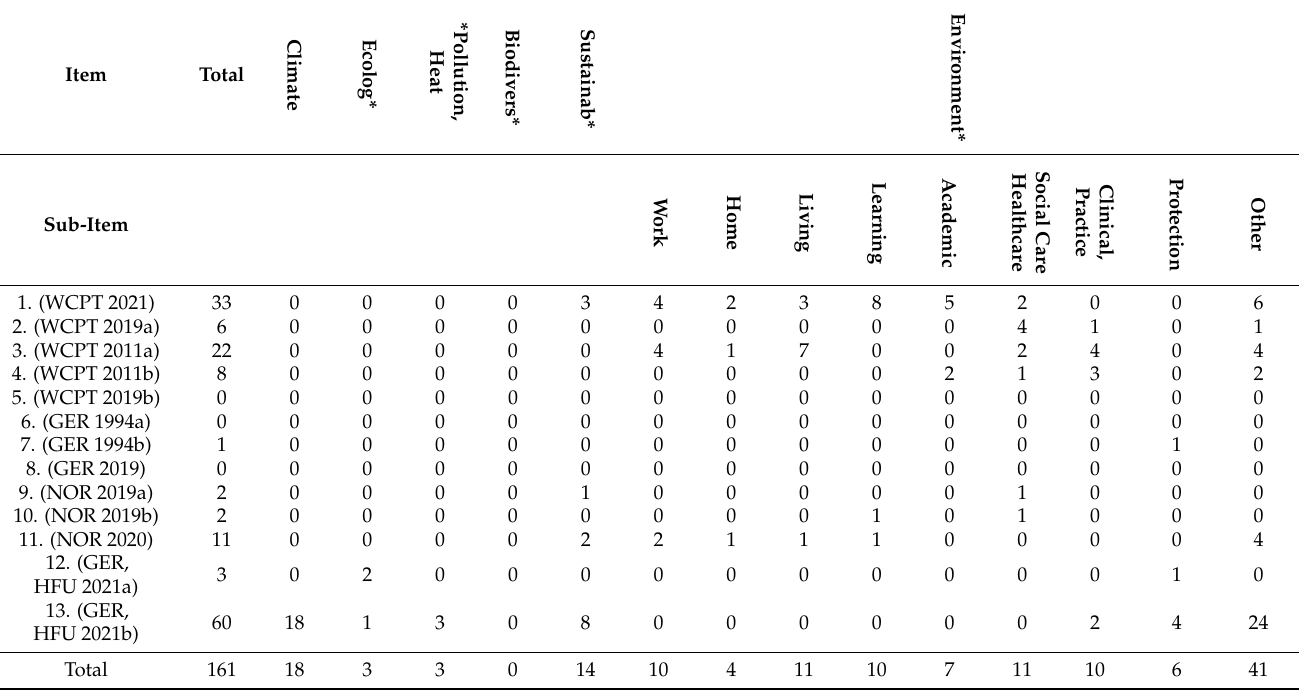
Table 3. Frequency of occurrence of sequence analysis categories across analyzed